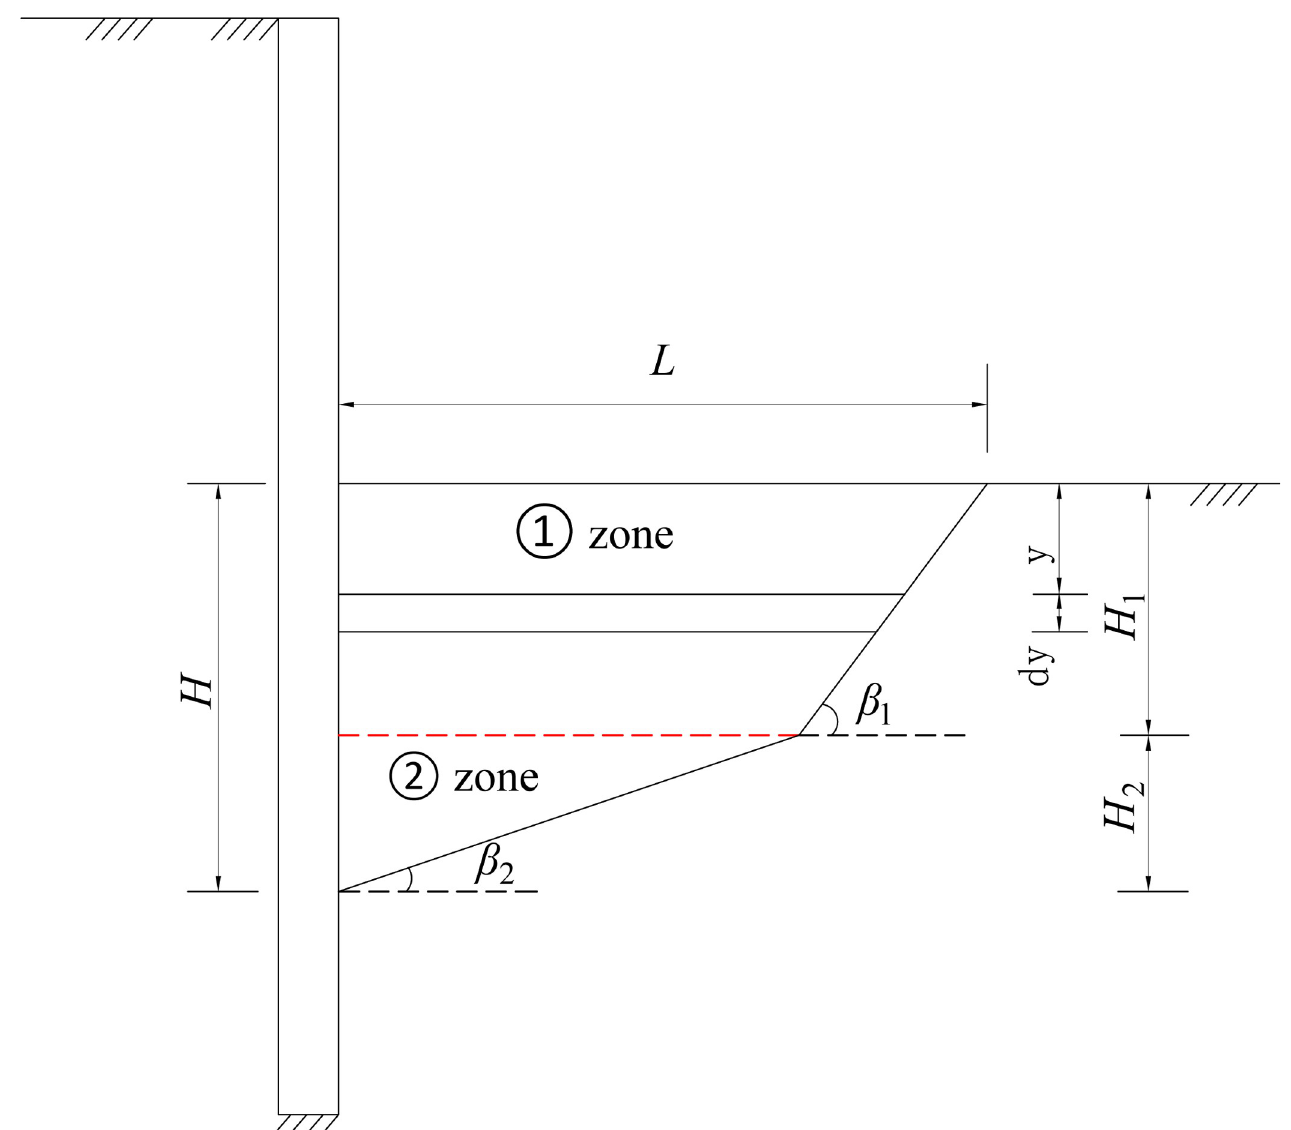
Fig 15. Sliding failure surface in passive